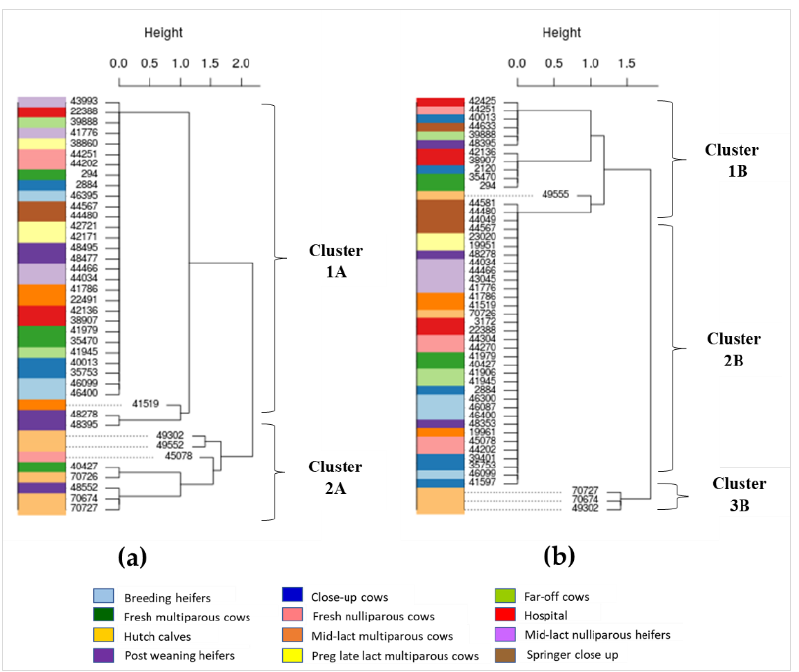
Figure 3. Phylogenetic clusters of E. coli and Enterococcus from dairy cattle at different production stages based on patterns of resistance genes detected from the ResFinder database. Numbers in the phylogenetic tree represent cattle IDs from which E. coli and Enterococcus were isolated: ( a ) E. coli ; ( b ) Enterococcus .